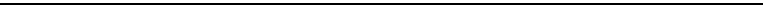
(see fi gure on previous page) Fig. 1 LCL-161 and birinapant reduce viability and number of differentiating OC. Human CD14 + -monocytes were treated with LCL-161 or birinapant at indicated concentrations throughout OC differentiation, typically 10-15 days ( A – E ). Representative phase-contrast images of TRAP- stained human OC, with arrowheads indicating multinuclear TRAP + cells. Frame in fi rst column indicates cutout for detailed view. Bar is 150 μ M ( A ). Fold change of TRAP + multinuclear cells after birinapant and LCL-161 treatment with or without in fl iximab (0.1 µg/ml) ( B ). Mean and standard deviations (SD) from 5 donors are shown. Single asterisk denotes statistical signi fi cance as compared to the untreated control or between indicated groups, double asterisk denotes statistical signi fi cance as compared to control treated with in fl iximab ( p < 0.05, One-way ANOVA). Representative fl uorescent microscope images of CD51/61-stained human OC, with arrowheads indicating multinuclear CD51/61 + cells ( C ) . Frame in fi rst column indicates cutout for detailed view. Bar is 150 µM. Fold change of multinuclear CD51/61 + cells after birinapant and LCL-161 treatment ( D ). 5 donors, mean and SD is shown. Asterisk denotes statistical signi fi cance as compared to the untreated control ( p < 0.05, One-way ANOVA). Viability at the time of TRAP + quanti fi cation ( E ) shown as average and SD of 5 donors. Asterisk denotes statistical signi fi cance as compared to the untreated control ( p < 0.05, One-way ANOVA). The viability of OC and M ϕ on day 10 of differentiation (F, G) measured with the Cell Titer Proliferation assay. 8 donors, mean, and SD are shown. Asterisk denotes statistical signi fi cance between groups, double asterisk denotes statistical signi fi cance between indicated controls ( F , G ) ( p < 0.05, One-way ANOVA).